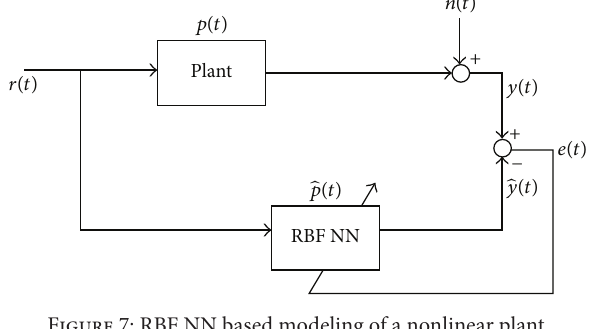
Figure 7: RBF NN based modeling of a nonlinear plant.